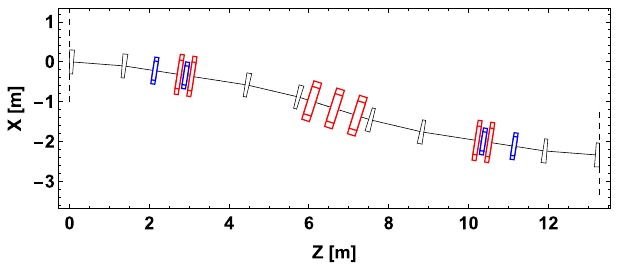
FIG. 5. Existing MAX IV bunch compressor 1. Dipoles in black, quadrupoles in red and sextupoles in